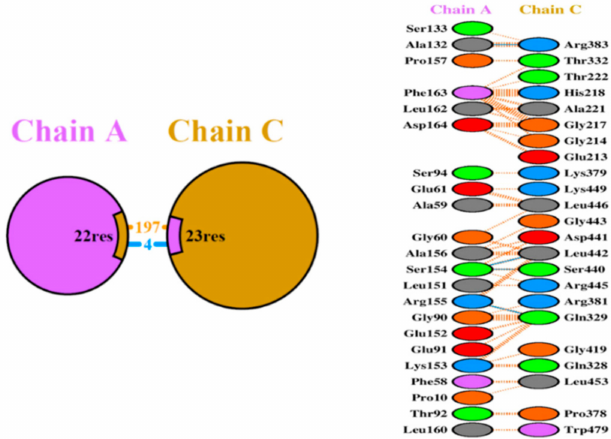
Figure 4. Schematic representation of the identified interactions occurring in the Ada-AlkA / Ogt model. Chain A represents Ogt while Chain C is